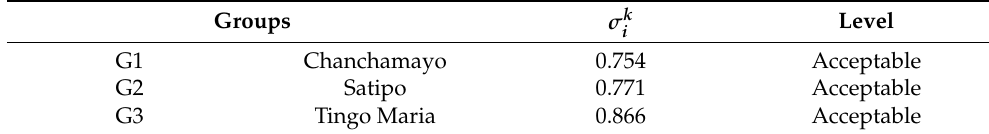
Table 13. Level of maximum clustering coefficients in the respective groups.